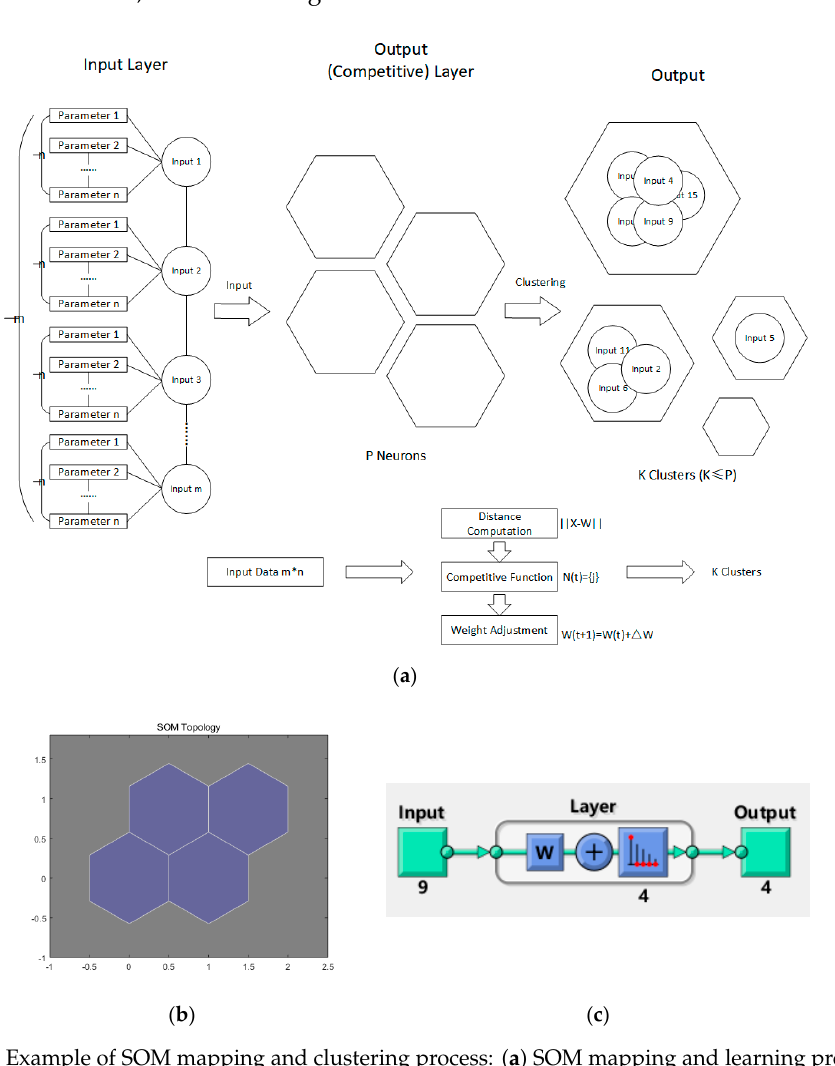
Figure 5. Example of SOM mapping and clustering process: ( a ) SOM mapping and learning process in clustering; ( b ) SOM topology in MATLAB; ( c ) SOM structure in view in MATLAB (e.g., nine inputs in the input layer and four neurons in the output layer).